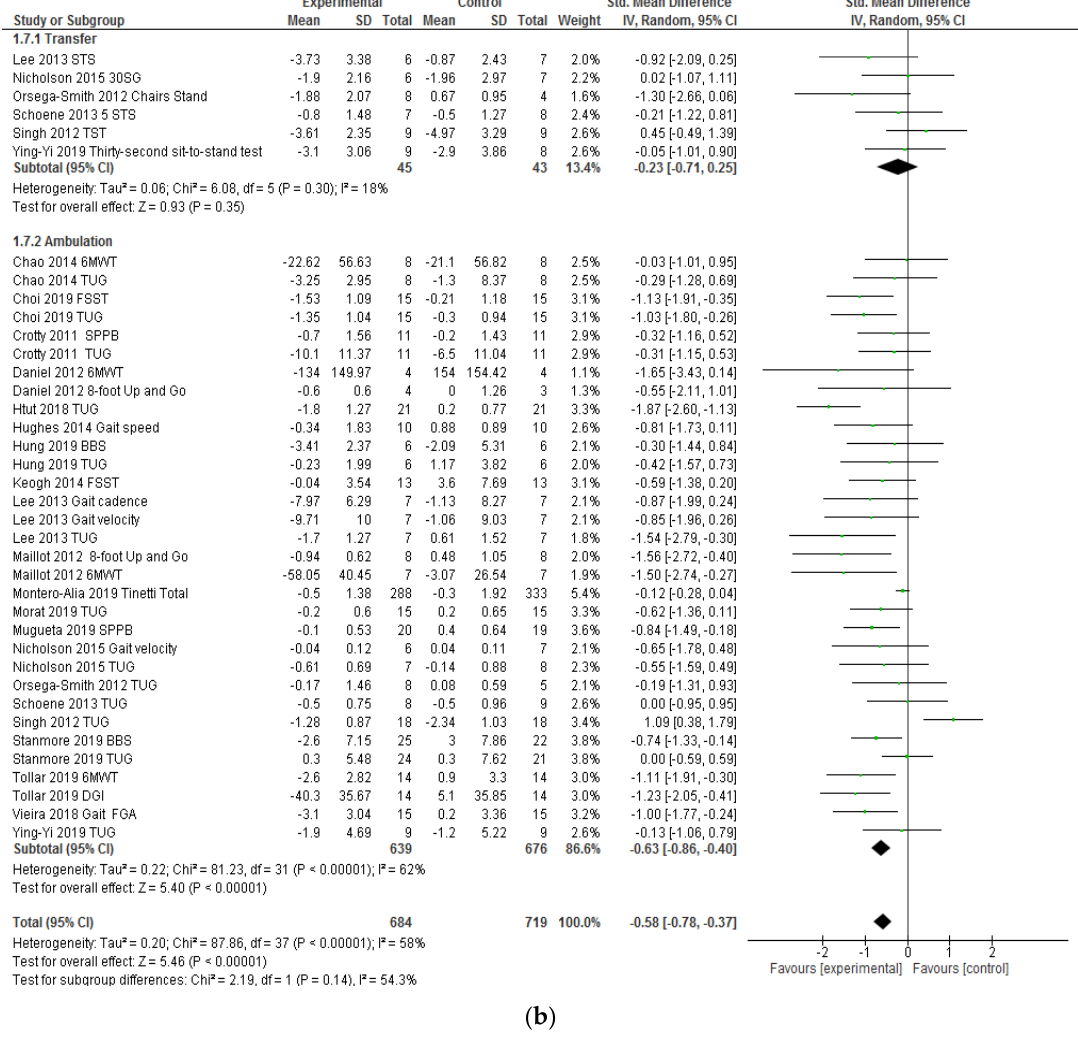
Figure 2. ( a ) Forest Plot illustrating effectiveness of VRSs on the activities of daily living (BADL and IADL). ( b ) Forest Plot illustrating effectiveness of VRSs on the transfer and functional ambulation.